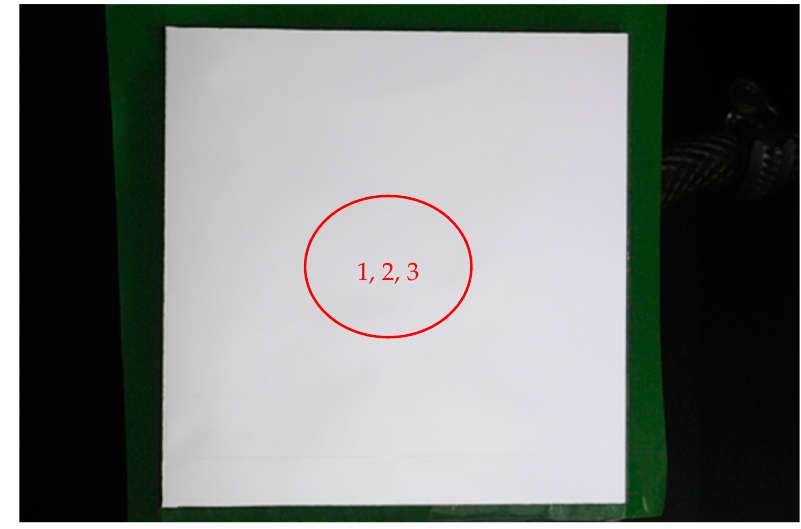
Figure 5. Three spots measured on each reflector sample with the spectrophotometer, according to the conventional measurement technique.